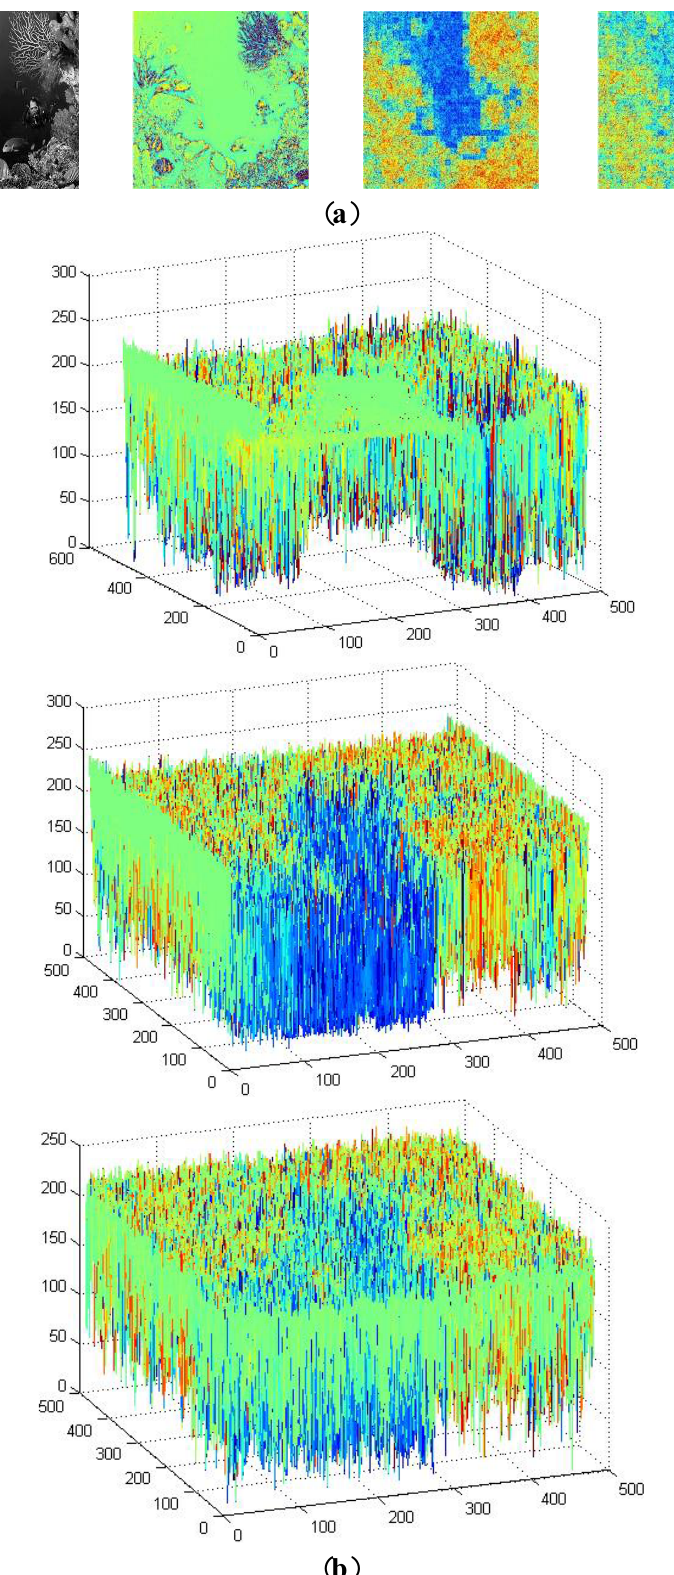
Figure 13. The feasibility of the navigation . ( a ) Original example image and the ICA responses; ( b ) 3D pixel map of the ICA outputs in the 1st, 2nd, 3rd layer; ( c ) Segmentation from the original image and the ICA response in the 2nd layer; ( d ) Traversable region recognition; ( e ) Navigation